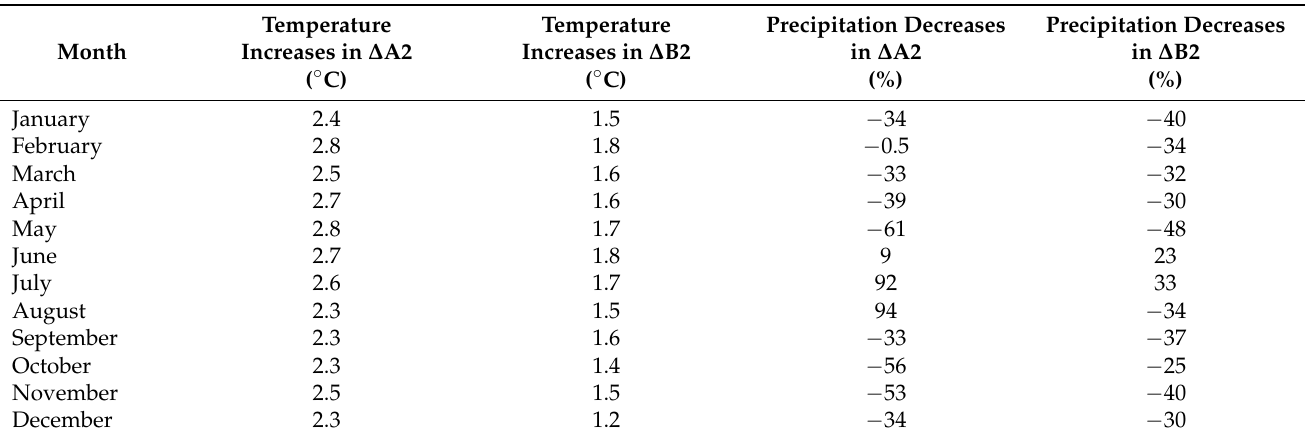
Table 2. Monthly temperature increase and precipitation decrease variations in the two simulated scenarios, according to Gomes et al. [5].